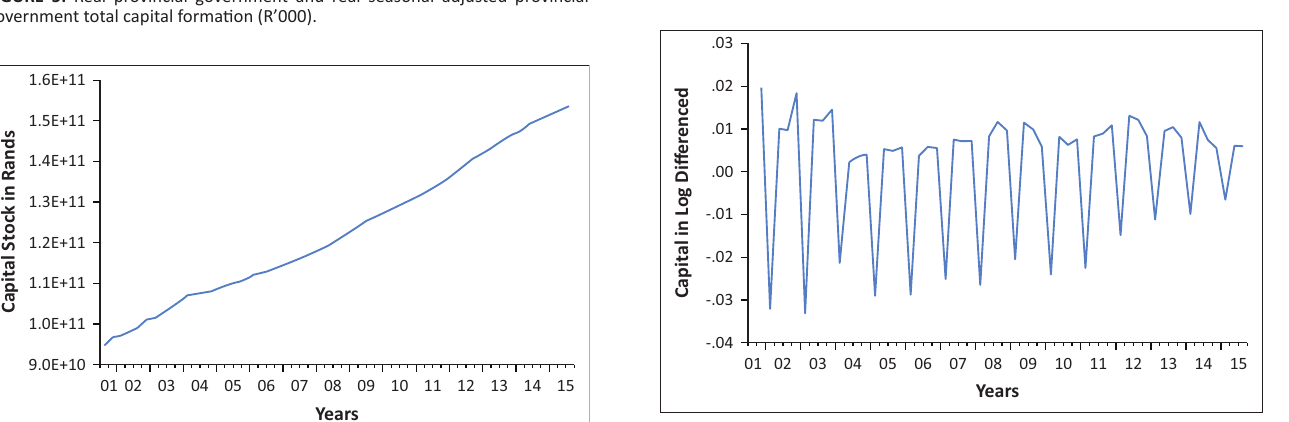
FIGURE 8: Log of first difference of the seasonal adjusted fixed provincial government capital stock per provincial skill adjusted labour